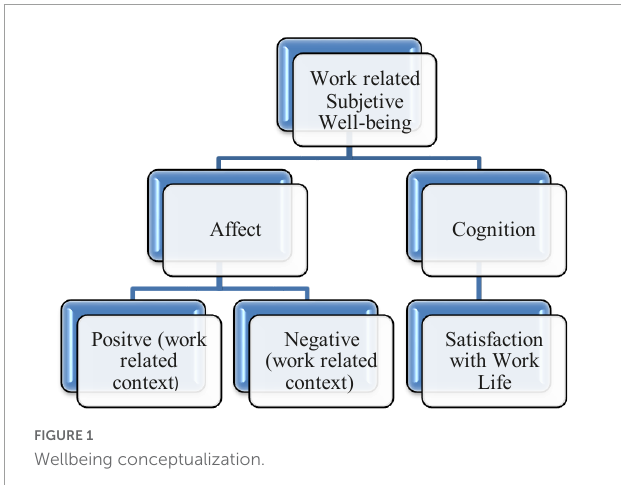
FIGURE1 Wellbeing